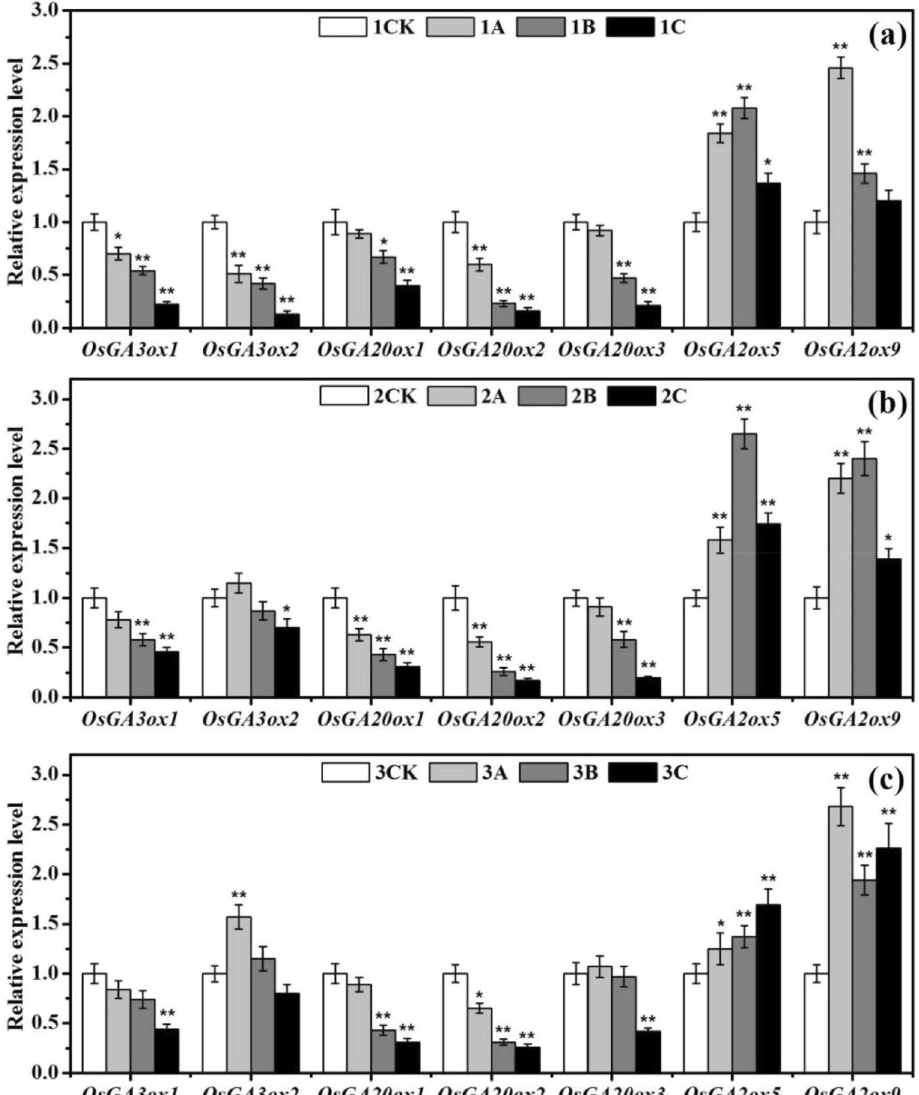
Figure 6. qPCR analysis of the key genes involved in gibberellin metabolism ( OsGA3ox1, OsGA3ox2, OsGA20ox1, OsGA20ox2, OsGA20ox3, OsGA2ox5, OsGA2ox9 ) in the nonirradiated and irradiated groups subjected to different doses of ionizing radiation. The results are reported as the relative expression of each gene with respect to an internal standard. The relative value of the expression of each gene in the nonirradiated sample was set to 1. The vertical bars represent the means ± SEs of three independent biological replicates ( n = 3). * and ** denote significance at the P < 0.05 and P < 0.01 levels, respectively, compared with the control group; ( a ), ( b ), and ( c ) represent XD10-01 ( ♀ ), BX10 ( ♂ ), and XJ (04)-08,